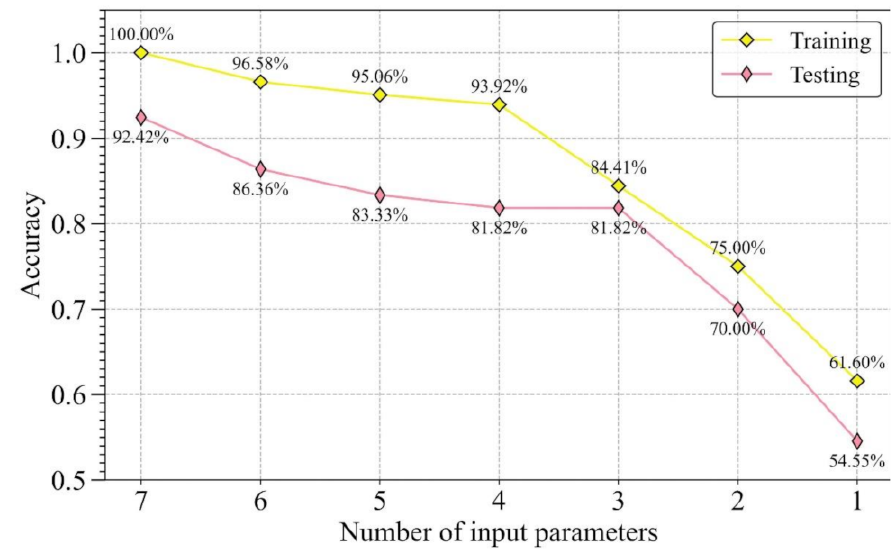
Figure 14. Model performance variation with the input parameters variation.